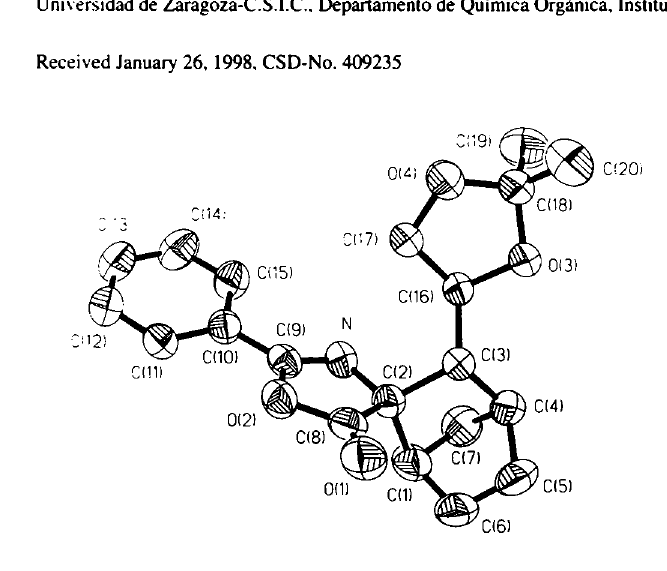
Table 1. Parameteis used for the X-ray data collection Crystal: